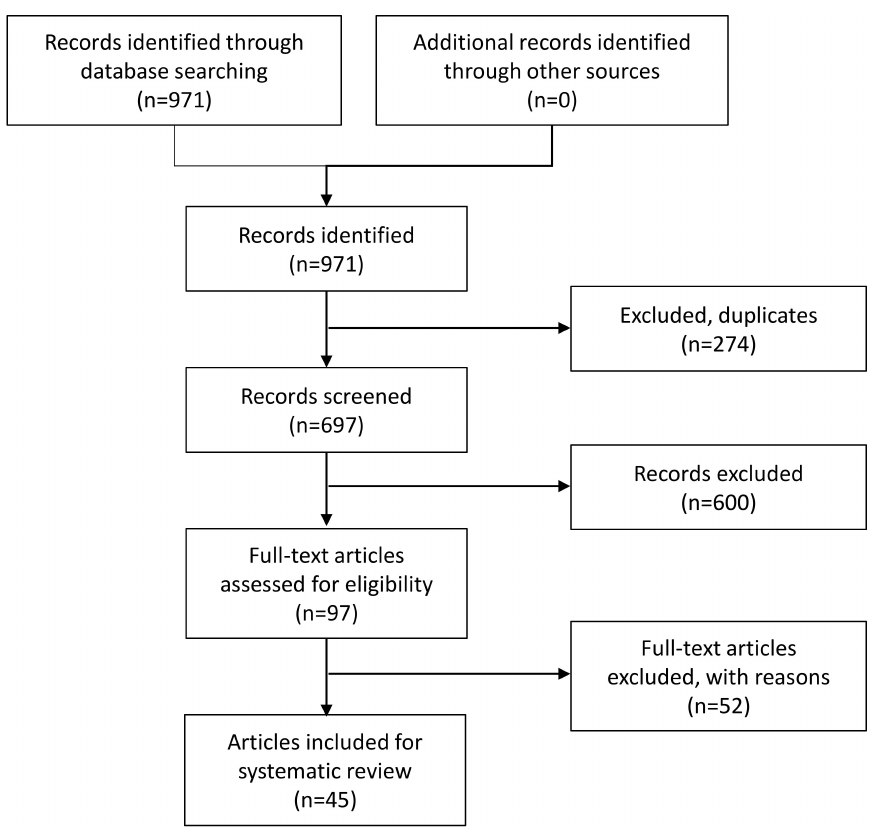
Figure A1. Article selection according to the MOOSE statement